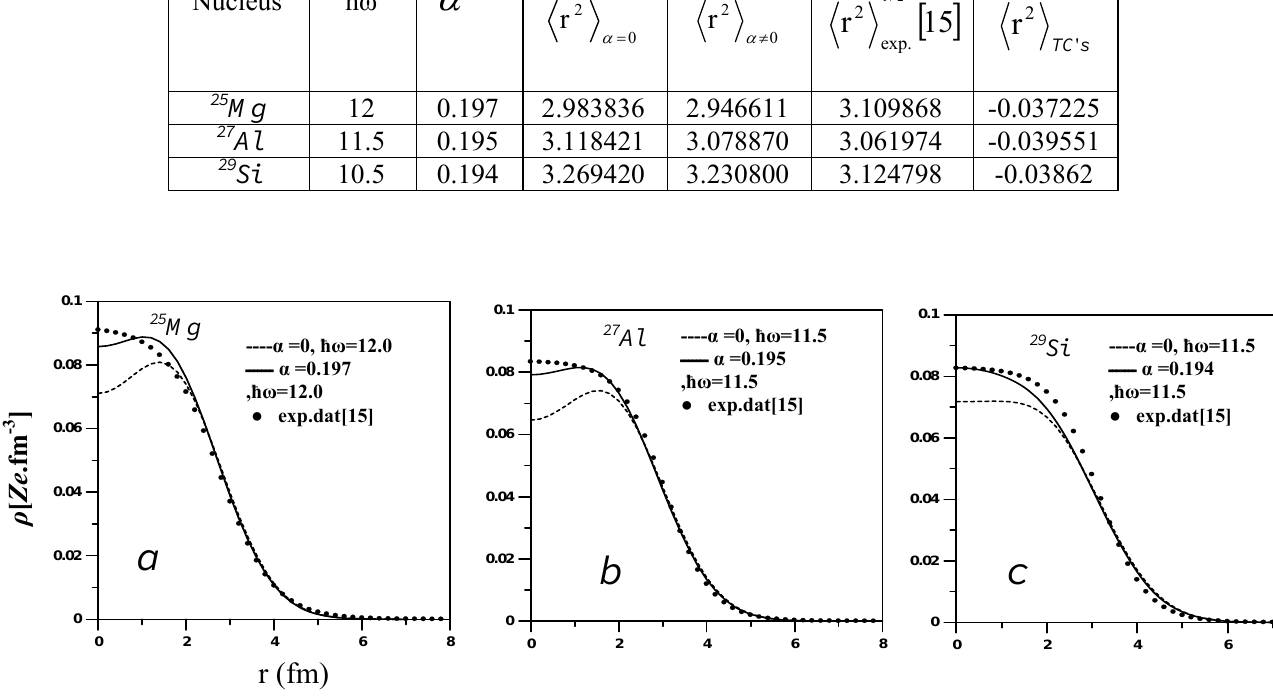
Fig.1(a, b and c): Dependence of the 2BCDD onr for 25 Mg, 27 Al and 29 Si nuclei respectively. The dotted symbols are the experimental data of Ref